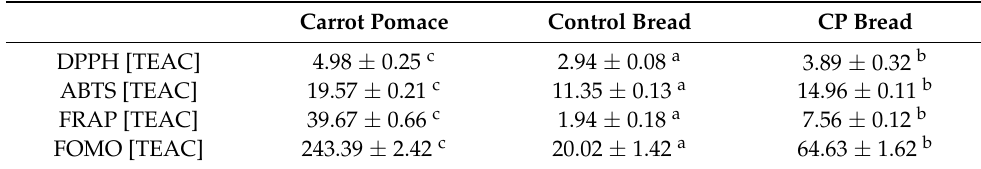
Table 5. Free-radical scavenging activity (DPPH, ABTS), Ferric reducing antioxidant power (FRAP), Molybdenum reducing antioxidant power (FOMO), Antioxidant activity of carrot pomace, control wheat bread and wheat bread enriched with 15% carrot pomace (CP). Carrot Pomace Control Bread CP